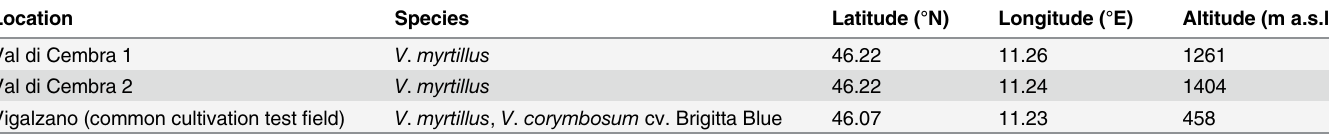
Table 1. Locations where bilberry plants where collected and later on cultivated in the test field.